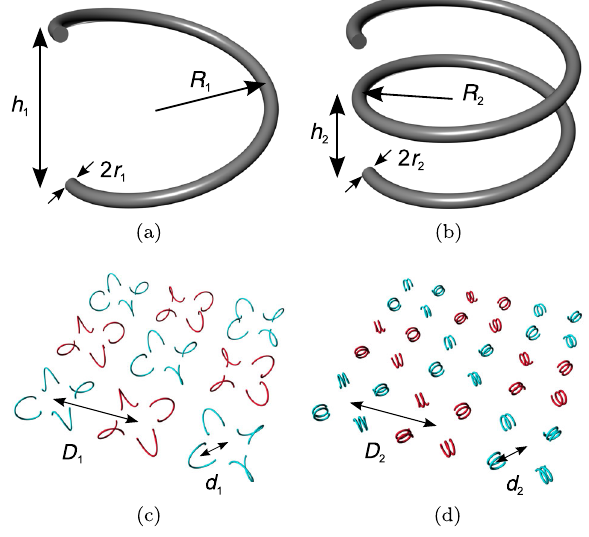
FIG. 3. (a) Single-turn and (b) double-turn helical inclusions. (c) Arrangement of the single-turn and (d) double-turn helical inclusions in the arrays. Blue and red colors denote right- and left-handed helices,